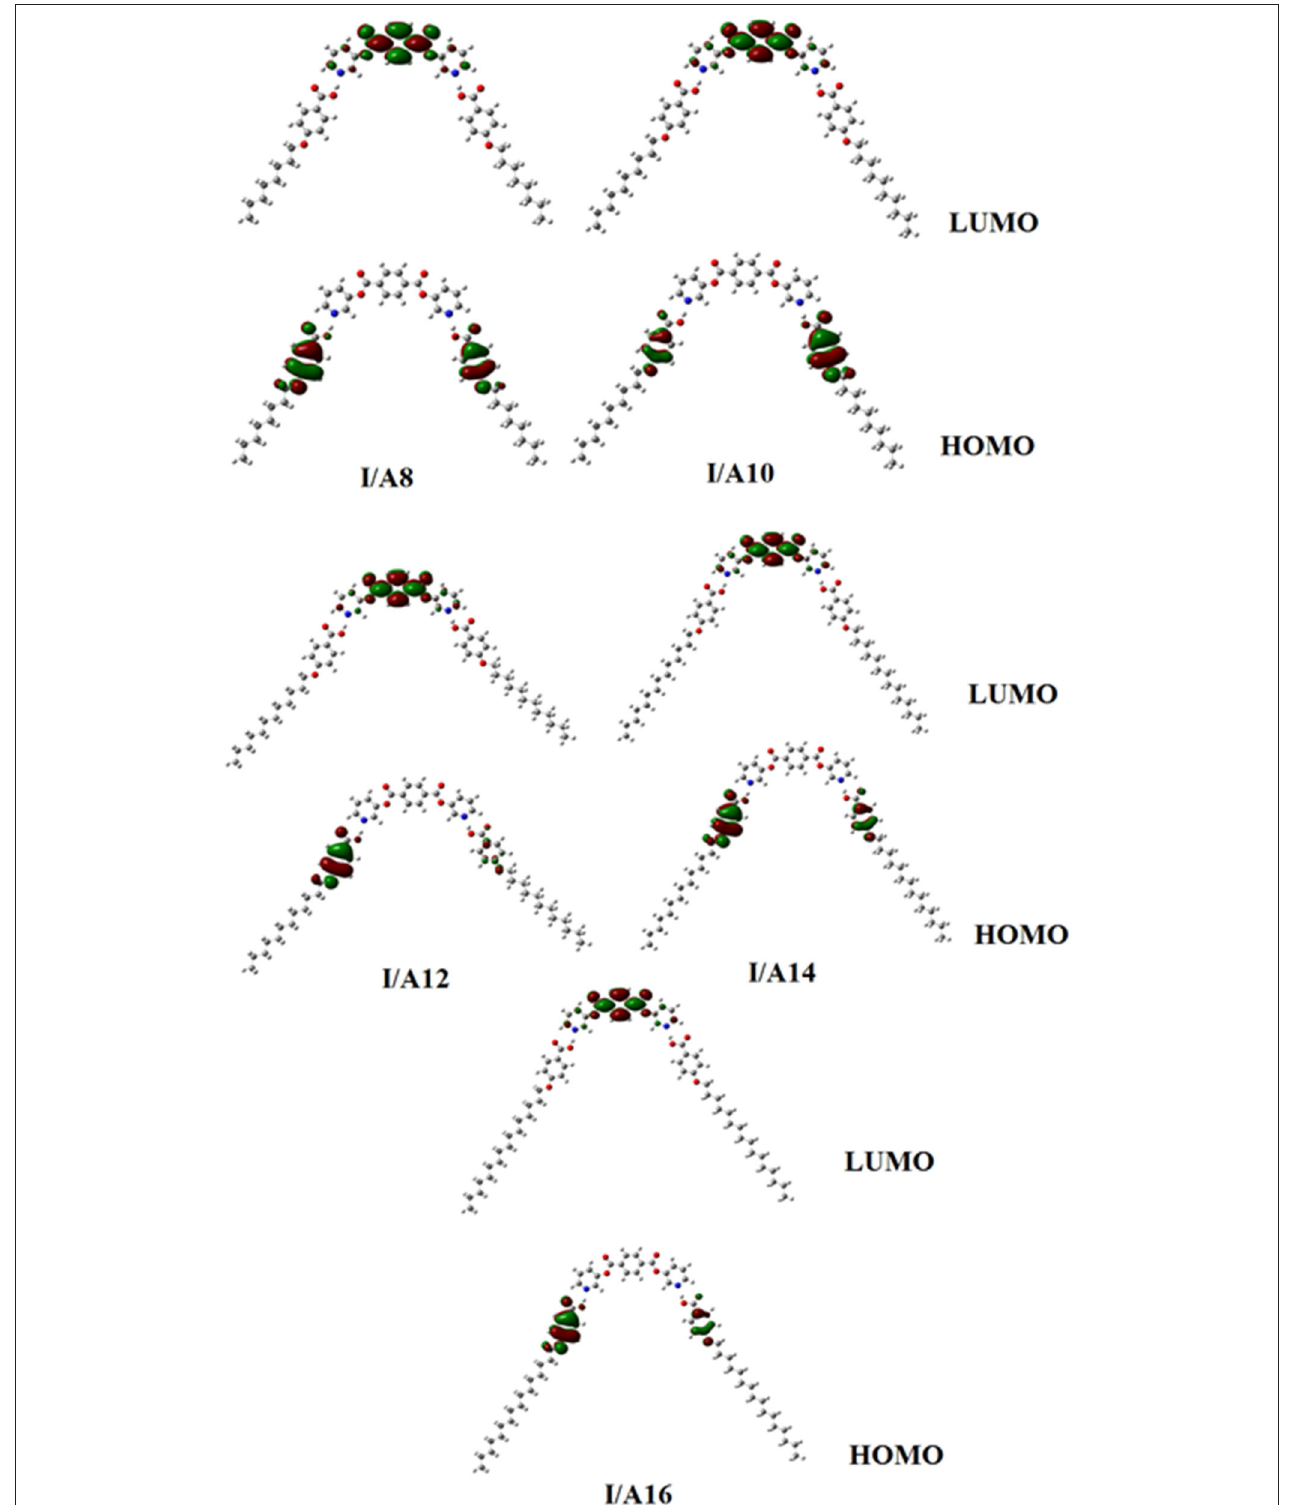
FIGURE 10 | Estimated plots for frontier molecular orbitals of SMHBCs, I/A n .